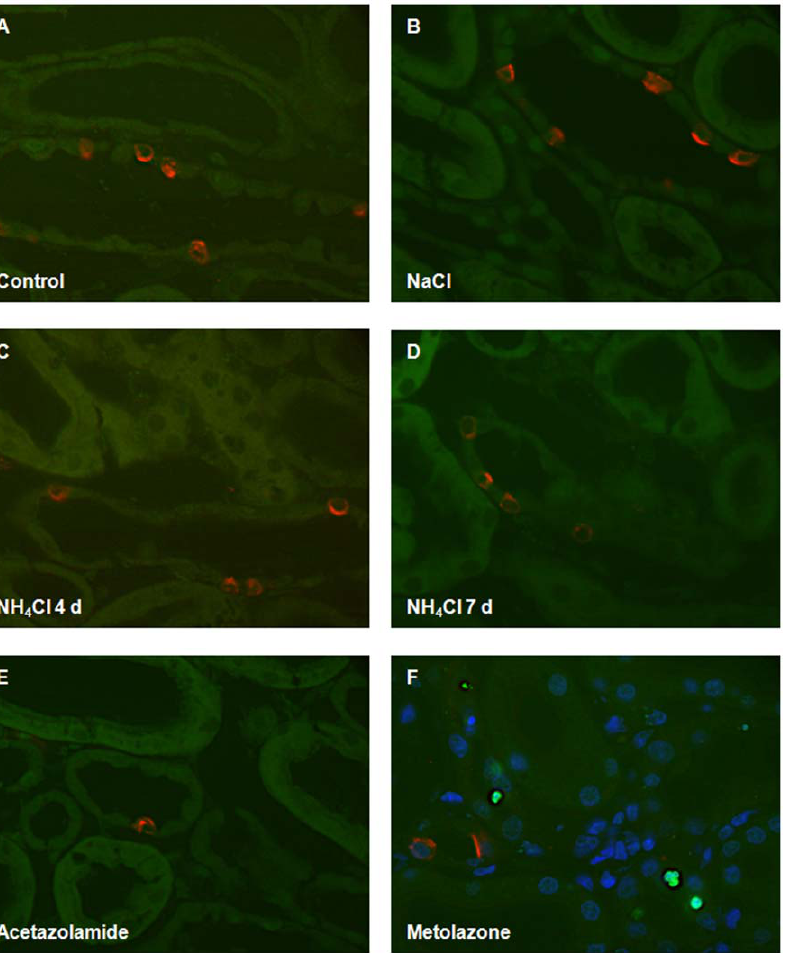
Figure 10. No detectable apoptosis of pendrin positive cells during metabolic acidosis. ( A–E ) Tissue sections were stained for pendrin (red) and TUNEL labelling (green) was performed to detect apoptotic cells. Under all conditions tested no apoptotic cells could be detected in the CNT, CCD or OMCD. ( F ) Apoptotic cells (green) were detected in kidneys from rats treated with the diuretic metolazone inducing apoptosis as described previously [50]. Cell nuclei were also stained with DAPI (blue). table 4. These observations are consistent with previous reports using similar treatments [11,13].